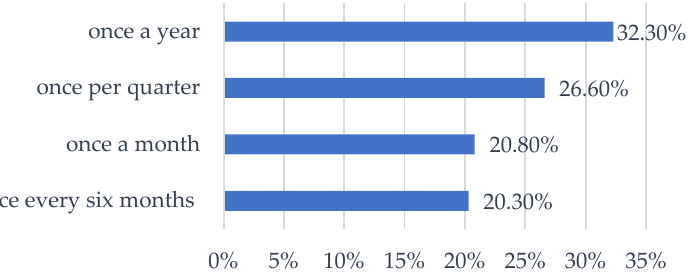
Figure 1. The frequency of collecting savings by the surveyed agricultural households. Note: scale 0–1; 0—variable is not important; 1—variable is very important. Source: own study.